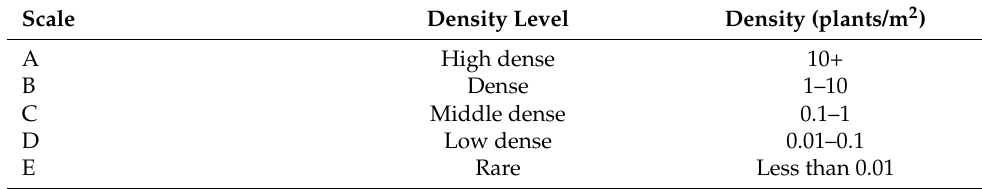
Figure 1. Experimental design. Table 3. Density scale of the